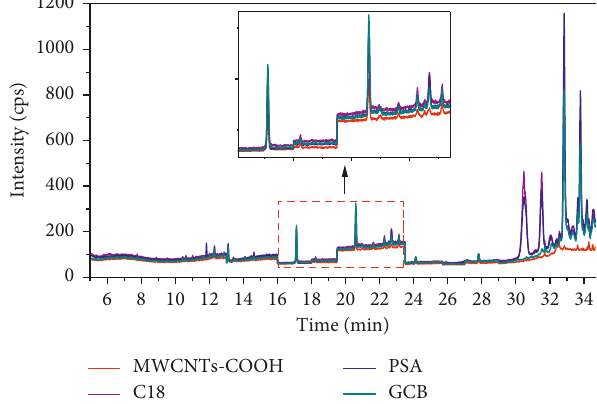
Figure 4: Chromatogram of the blank cucumber extract prepared using different adsorbents during the d-SPE